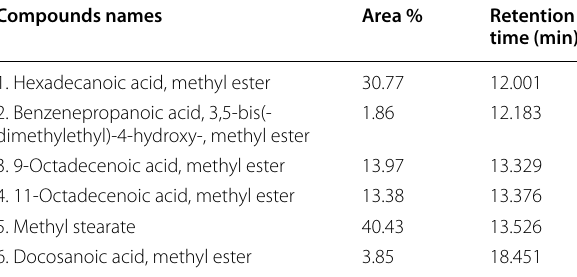
Table 12 Phytochemical Constituents of Methanol Extract